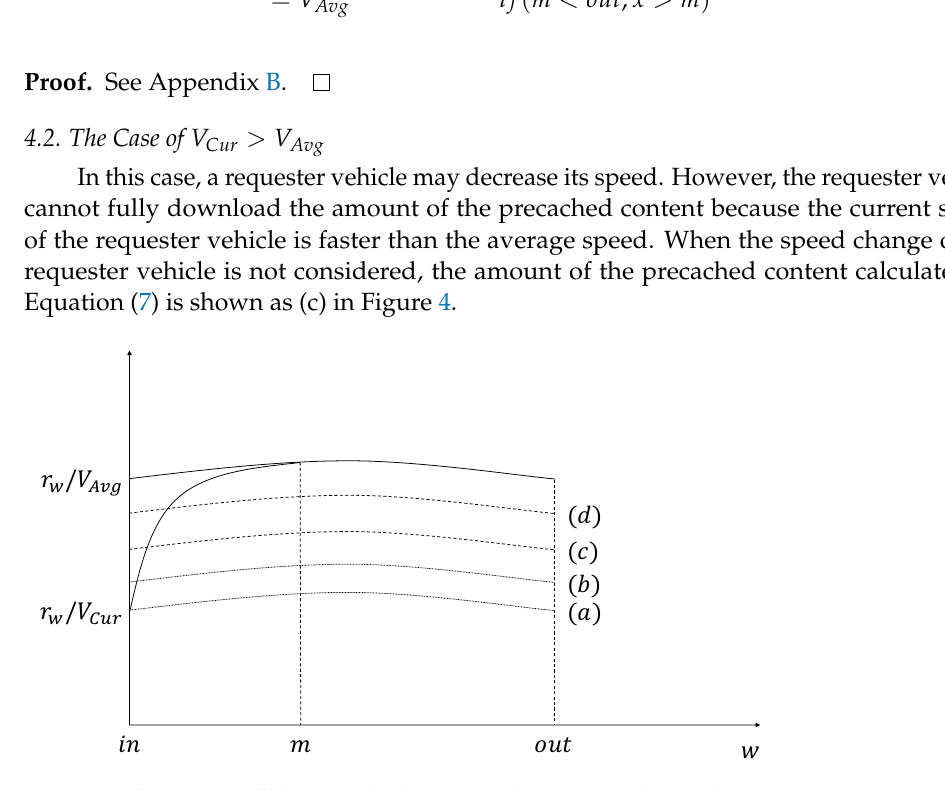
Figure 4. The amount of the precached content when V Avg is slower than V Cur